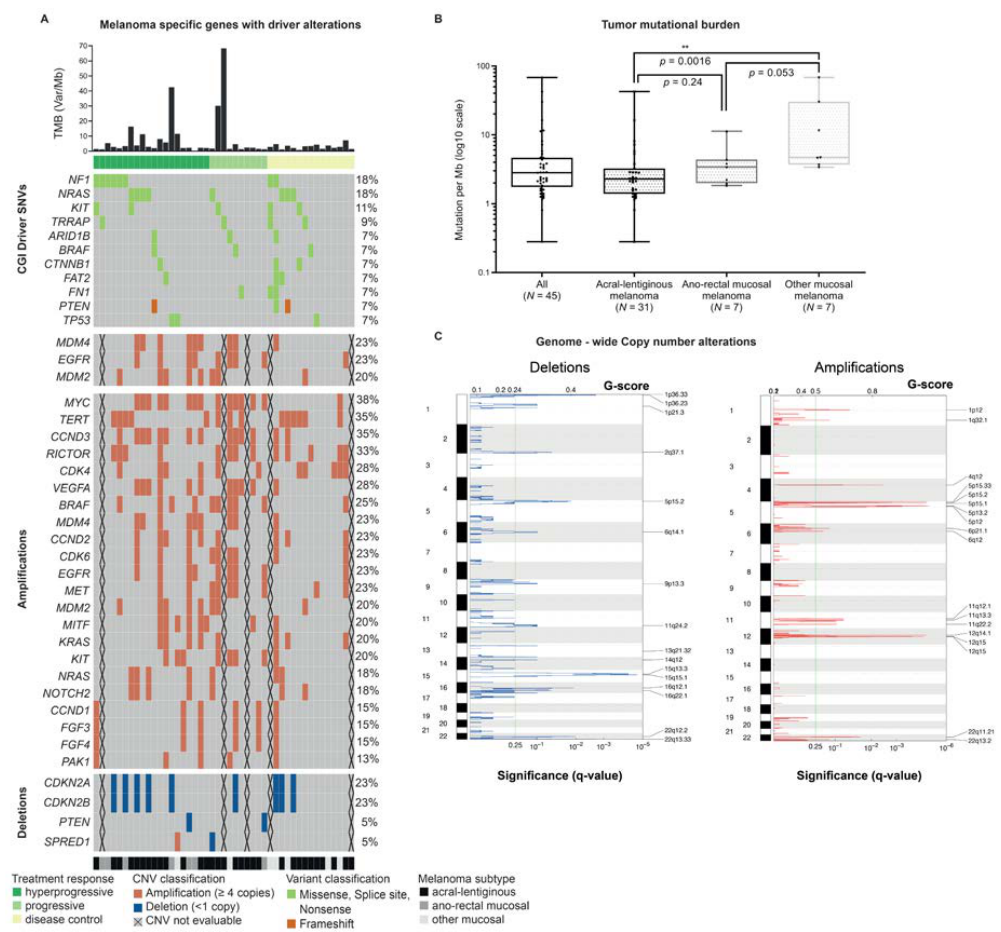
Figure 2. Mutational landscape of the cohort: tumor mutational burden (TMB), single nucleotide variants (SNVs), copy number variants (CNVs). The figure shows the most frequent alterations found in the 45 cases analyzed by whole-exome sequencing. The oncoplot ( A ) Melanoma specific genes with driver alterations depicts a list of genes filtered with the Cancer Genome Interpreter for known and predicted driver alterations. The upper part shows the tumor mutational burden (TMB) of each patient shown on a decimal scale (Mut / Mb). The oncoplot presents in the second panel from the top all genes with at least 3 mutations (SNVs and INDELs) in two di ff erent patients, translating to a minimal alteration frequency of 7%. The genes are sorted according to their alteration frequency and alphabetically. Each row represents a patient. The patients are sorted according to their melanoma subtype (acral-lentiginous, anorectal mucosal and other mucosal melanoma). Also, the response to the checkpoint inhibitors is shown (hyperprogression, progressive disease and disease control). In addition, the two lower panels depict somatic copy number alterations of particular interest. The lower panel shows somatic SNV and alteration frequency of all driver alterations found in the significantly altered genomic region shown in ( C ). The middle panel displays MDM4 , EGFR and MDM2 . On the right hand ( B ), the upper part Tumor mutational burden depicts the results of the comparison of the TMB between the three di ff erent melanoma subtypes. The boxplots show all data points, median, interquartile borders as well as minimum and maximum. The t -test (Wilcoxon-rank test) revealed a significant di ff erence while comparing the TMB of acral-lentiginous (median: 2.28, range: 0.28–42.54) and other mucosal melanoma (median: 4.68, range: 3.38–68.34), meaning in acral-lentiginous melanoma, a significant lower TMB was observed compared to other mucosal melanoma. ** significant di ff erence in the Wilcoxon-rank test. The lower part ( C ), Genome–wide Copy Number Alterations presents the results of the GISTIC analysis. GISTIC identified 16 regions on 11 chromosomes to be significantly deleted and 18 regions on 7 chromosomes to be significantly amplified. The cut-o ff for calling the regions is 0.25